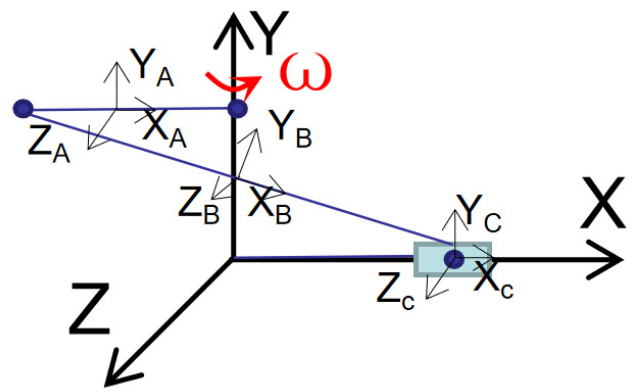
Figure 2. Schematic diagram of spatial crank-slider model. The crank and ground are connected by rotating joint and spherical joints are formu- lated at both ends of the connecting rod with the crank and slider.